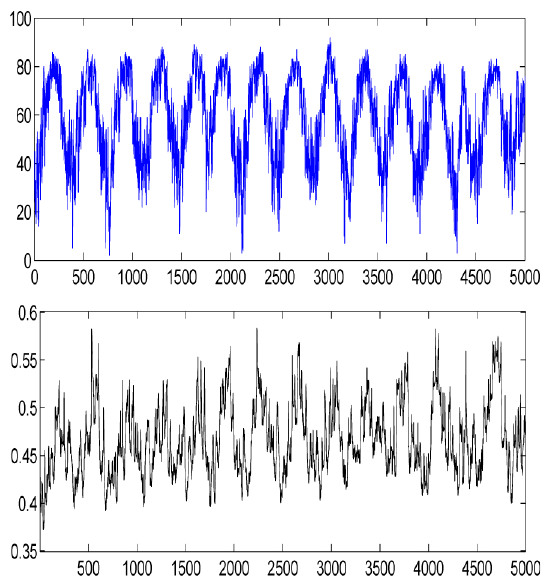
Fig. 10. Mean temperatures at the Corning station (top), and esti- mated pointwise regularity